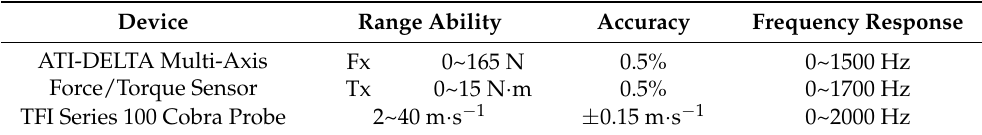
Table 3. The performance parameters of the measuring equipment.